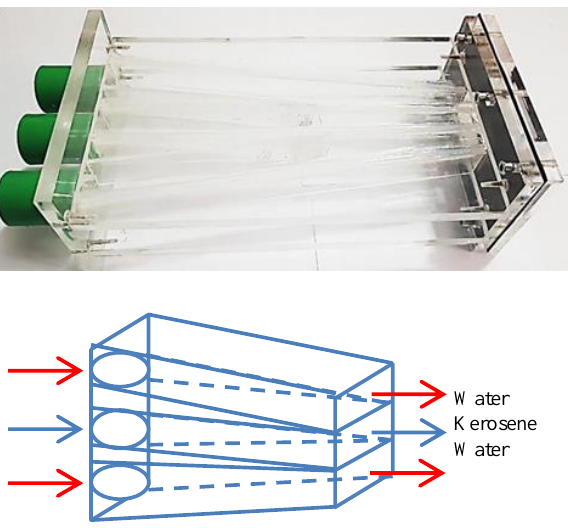
Fig. 3: Adjustment for circular to rectangular cross section Figure 3: Adjustment for circular to rectangular cross